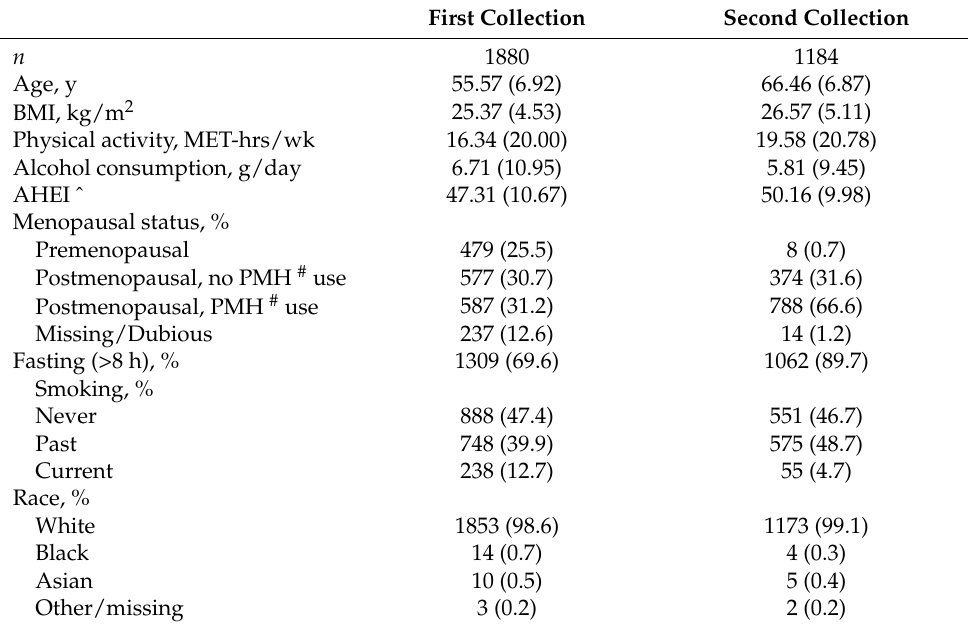
Table 4. Characteristics of study participants in the primary